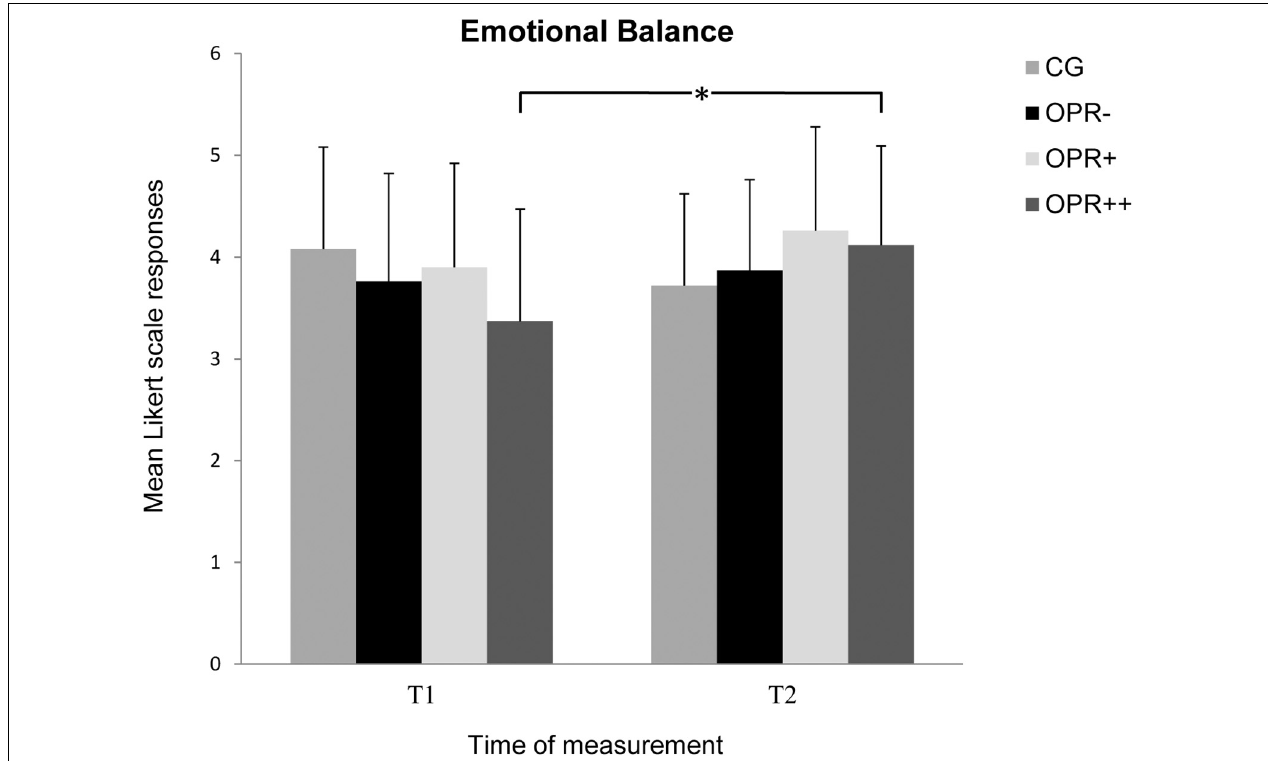
FIGURE 4 | The mean values of the Emotional Balance of the groups as a function of the time of measurement (T1, T2). The symbols represent across-participant means, and error bars show standard deviations. The 7-point Likert scale ranged from “does not apply at all” (0) to “fully applies” (6). (CG: control group without any intervention; OPR - group: got a filled bottle of water every day without any label on it; OPR + group: got a filled bottle of water every day with the label “Imagine I Am Health”; OPR ++ group: got a filled bottle of water every day with the label “Imagine I Am Health” and an audio file with a health mediation) (*p <